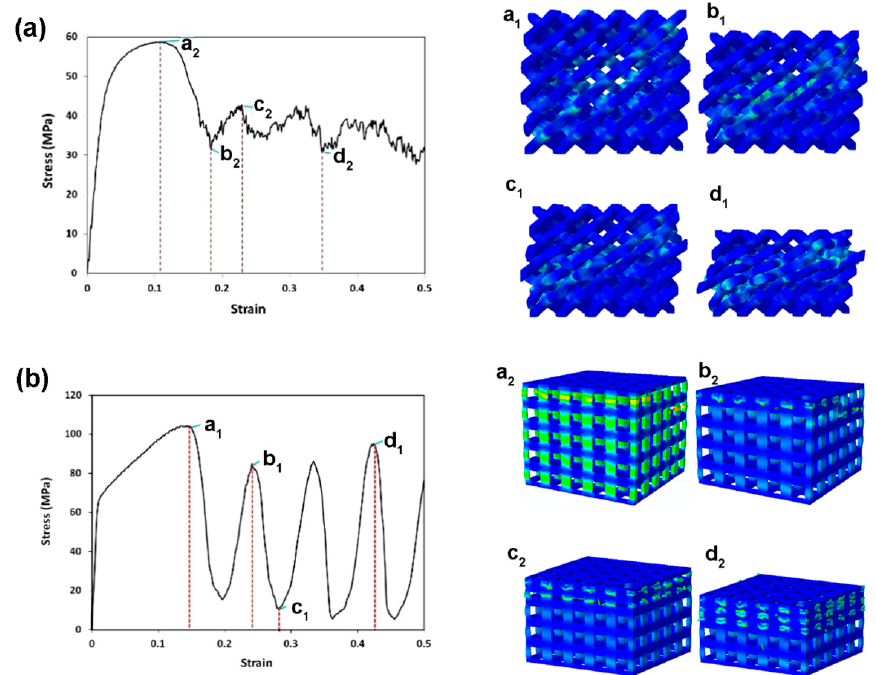
Figure 3. Failure mechanisms of ( a ) the diamond lattice structure at a 22% volume fraction; continuous shearing band of 45°, owing to crushing diagonal layers, is observed. Shearing of layers is accompanied by the bending failure of tying struts perpendicular to the diagonal plates; and ( b ) the cubic lattice structure; layer-by-layer deformation mechanism is confirmed by stretch-dominated deformation in scaling law analysis [98].